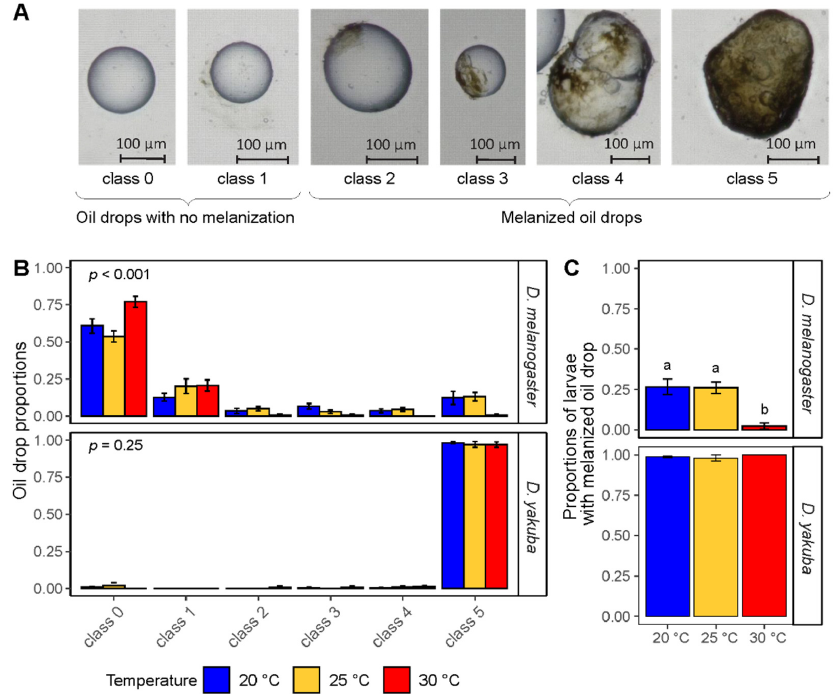
Figure 3. Impact of temperature on the host encapsulation capacity. ( A ) Example of oil drops with different degrees of encapsulation, ranging from class 0 = “no host response” to class 5 = “strong melanization response”. ( B ) Capacity of D. melanogaster and D. yakuba to encapsulate an oil drop as a function of temperature. Proportion of host larvae containing oil drops with different level of melanization. p on top left is the p-value from the Fisher Exact Test. ( C ) Capacity of D. melanogaster and D. yakuba to encapsulate an oil drop as a function of temperature. Proportion of host larvae able to induce a melanized response (i.e., containing oil drops with at least one melanization spot on the oil drop). Different letters indicate a significant difference between temperatures. Bars indicate standard errors (see Supplementary Tables S5 and S6 for sample sizes and statistical outputs).